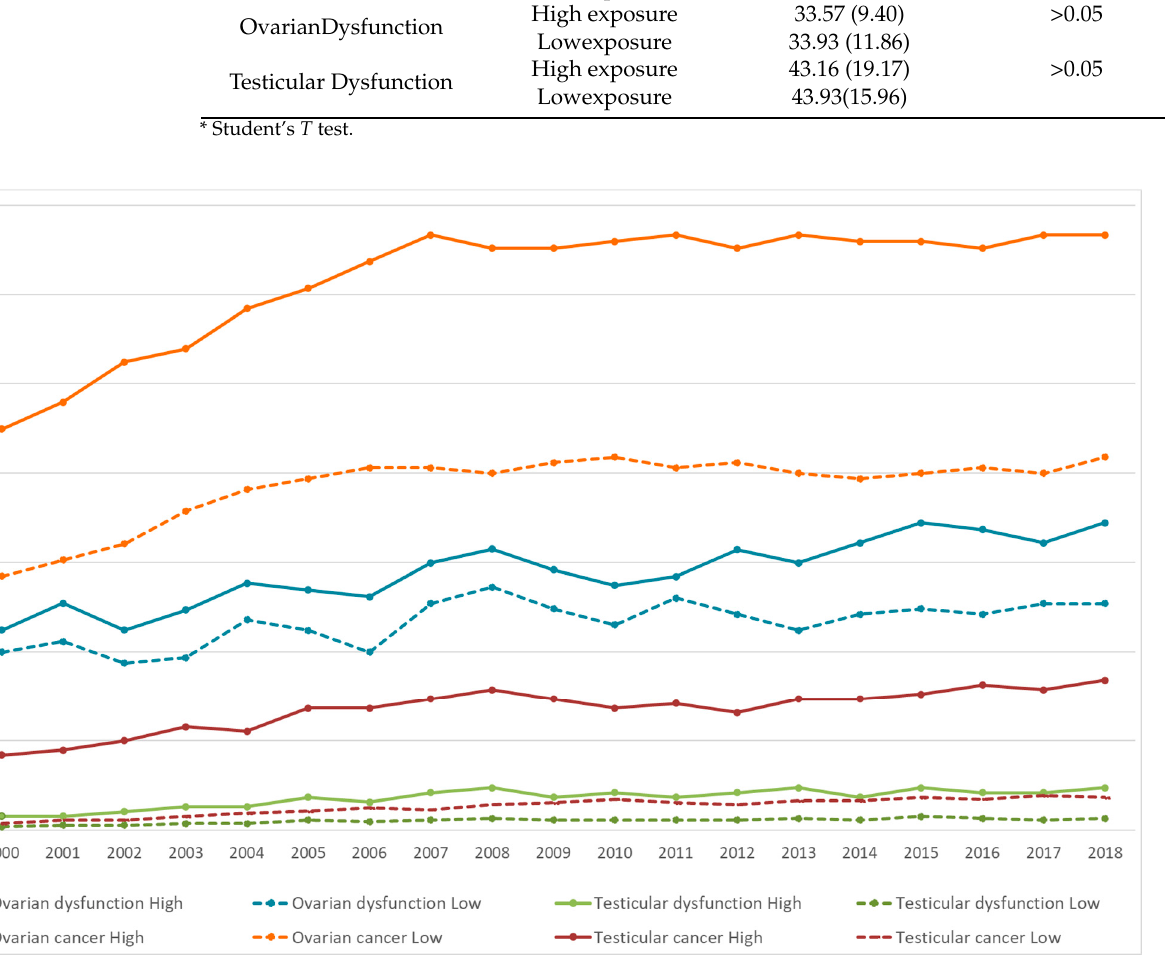
Table 2. Prevalence (rate per 1000 inhabitants), odds ratio (OR), and 95% confidence interval (95% CI) for gonadal diseases in the population living in areas of high pesticide exposure relative to areas of low exposure.